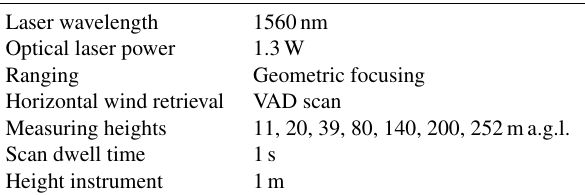
Table 1. Key parameters of a ZX 300 wind lidar. The measure- ment heights are specific to the Cabauw site; all other parameters are generic.